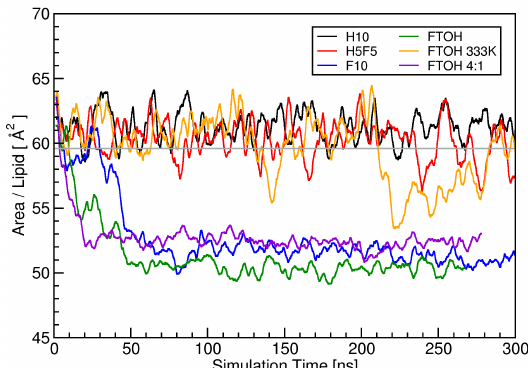
Figure 5. Temporal development of the lateral area per lipid during simulation runs. The gray line depicts the average value of the pure membrane.